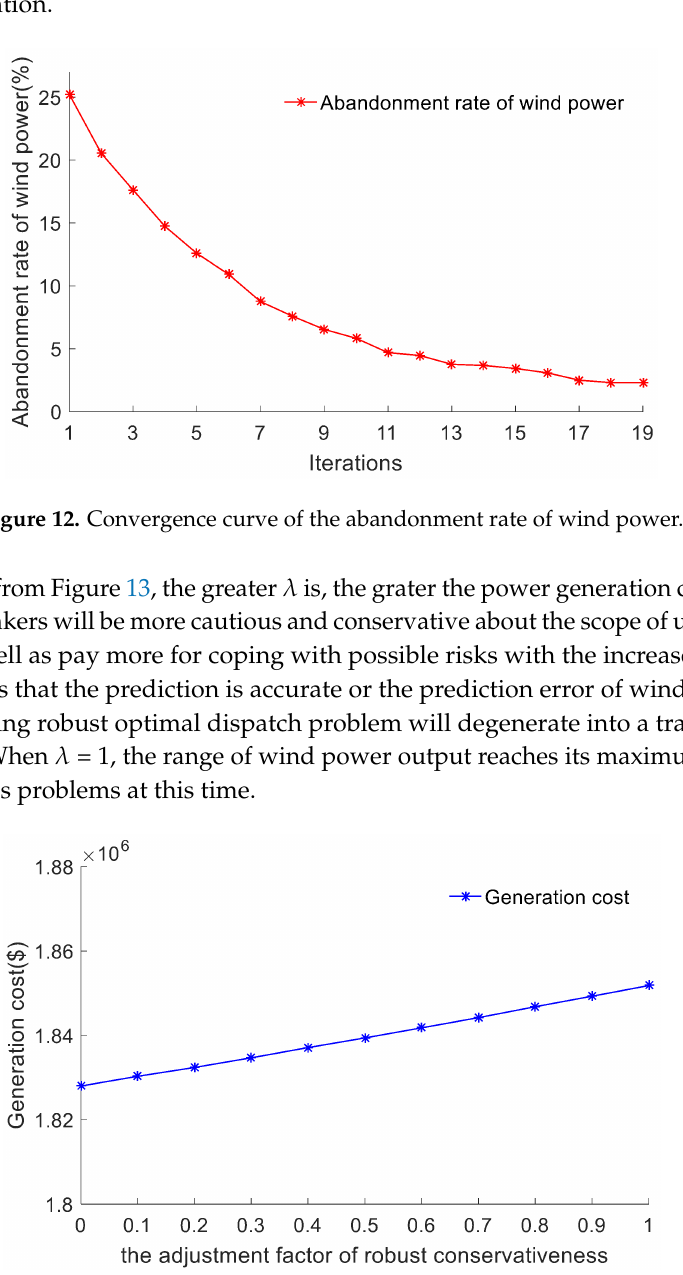
Figure 13. Influence of the adjustment factor of robust conservativeness on generation